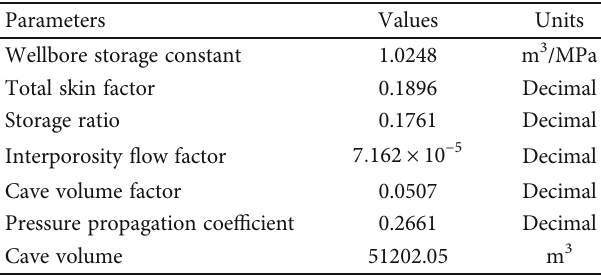
Table 3: Matching